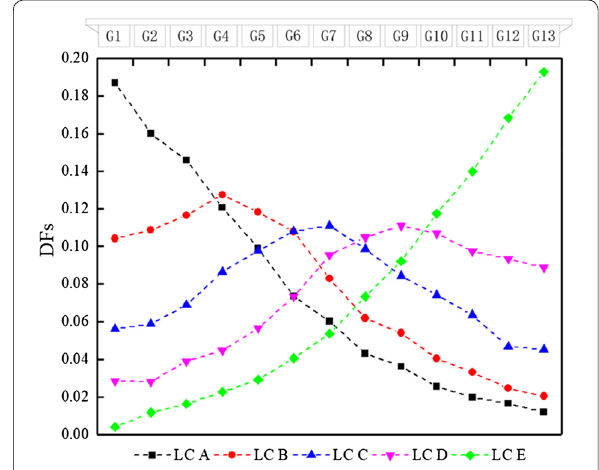
Fig. 12 DFs in different loading